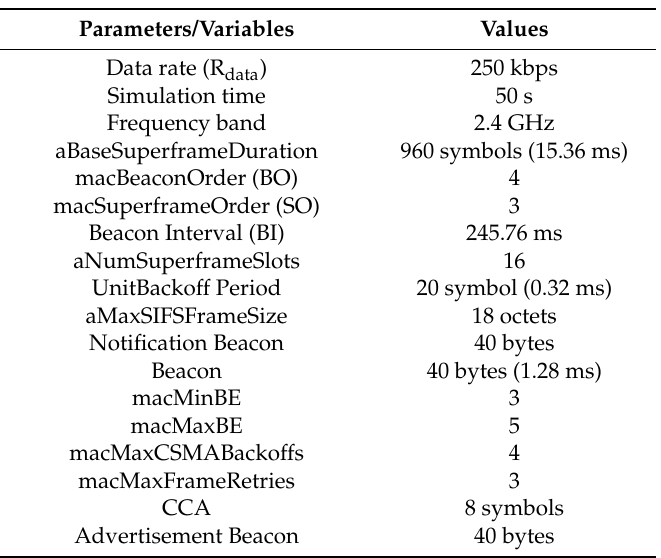
Table 5. Simulation